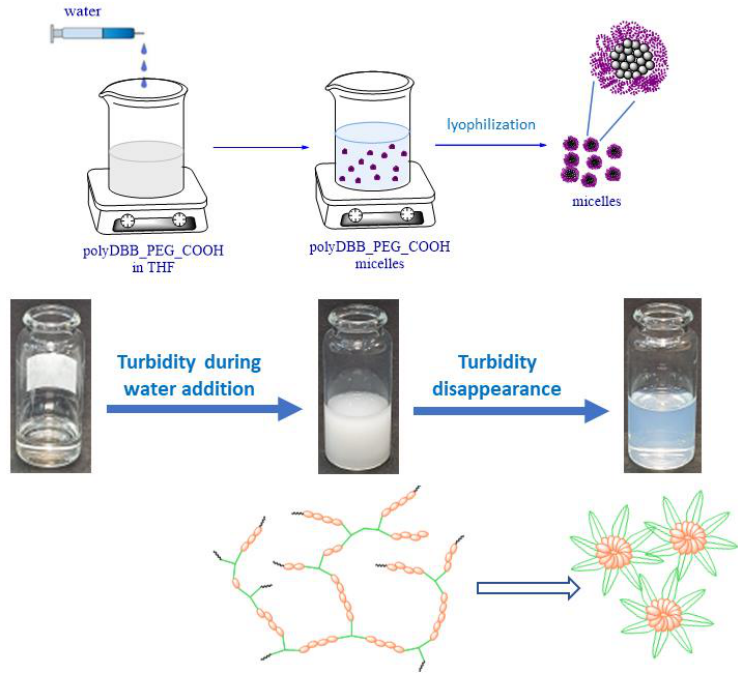
Figure 11. Scheme of micelle preparation.